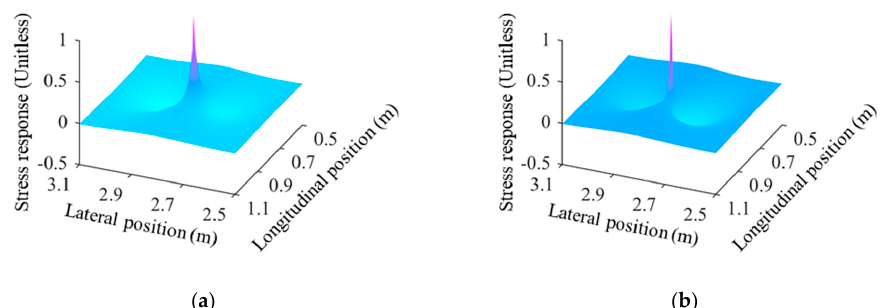
Figure 11. Unitised influence surface of joint U12 L : ( a ) Nominal stress; ( b ) Hot spot stress.